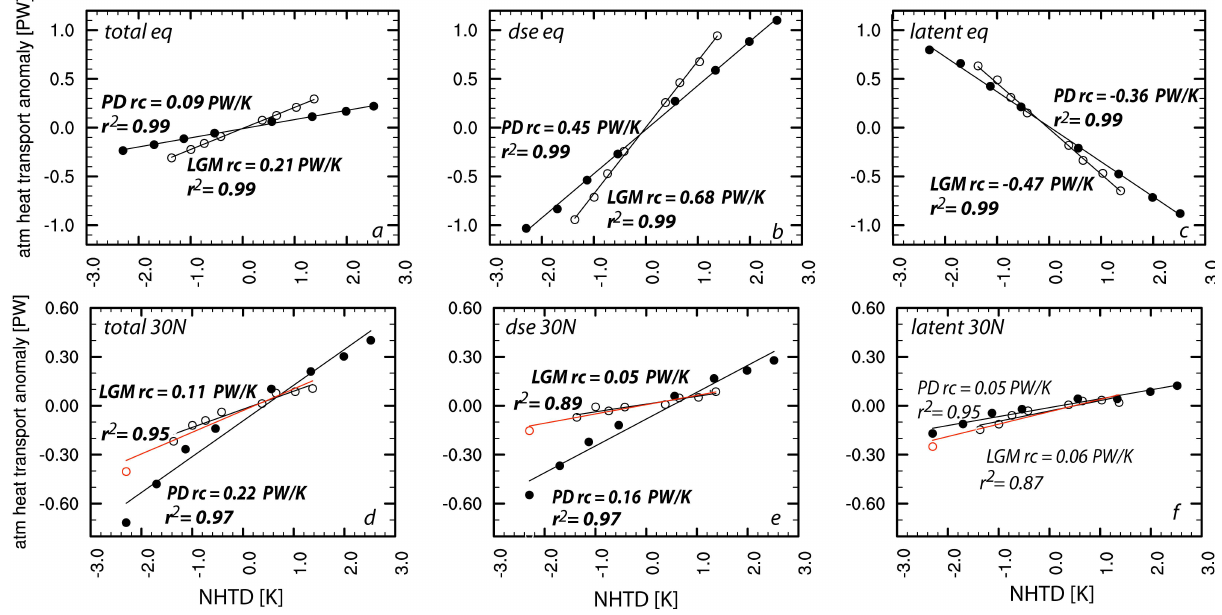
Fig. 2. Atmospheric transport anomalies (PW) at the equator (a, b, c) and 30 ◦ N (d, e, f) for PD (full circles) and LGM (open circles) simulations as a function of NHTD anomaly (K). Positive/negative NHTD anomalies refer to NH cooling/warming. Linear regression coefficients and r 2 values of the fit are indicated. Bold font indicates that the difference between PD and LGM slopes is statistically significant at the 95% level. Red open circle represents the LGM p3 experiment.